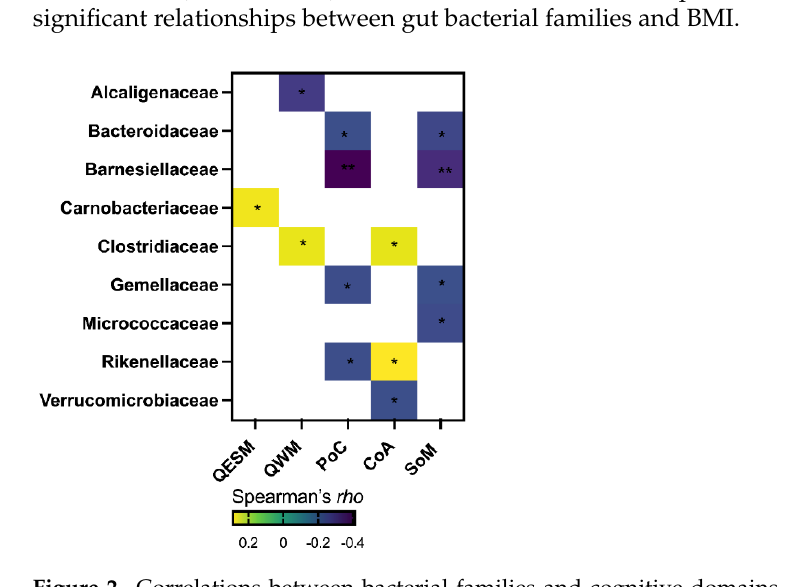
Table 4. Bacterial families in the prediction of cognition per domain, adjusted and unadjusted regression